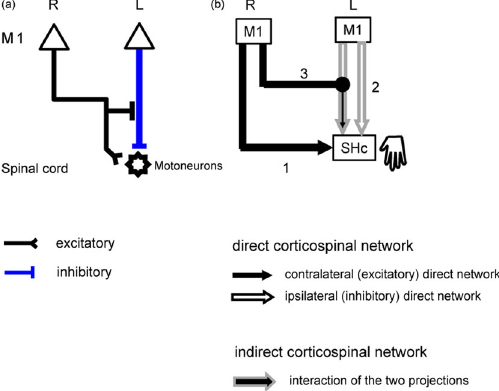
Fig. 2 Effective connectivity between M1 and SHc and a proposed network model for LHM. a The positive effective connectivity underpins the net excitatory in fl uences onto the motoneurons (black line; see also Fig. 1b), and negative effective connectivity represents the net inhibitory effects on motoneurons (blue vertical line; see also Fig. 1d). Signals from right contralateral M1 may exert modulation of the negative effective connectivity (black horizontal line, see also Supplementary Fig. 6) 33